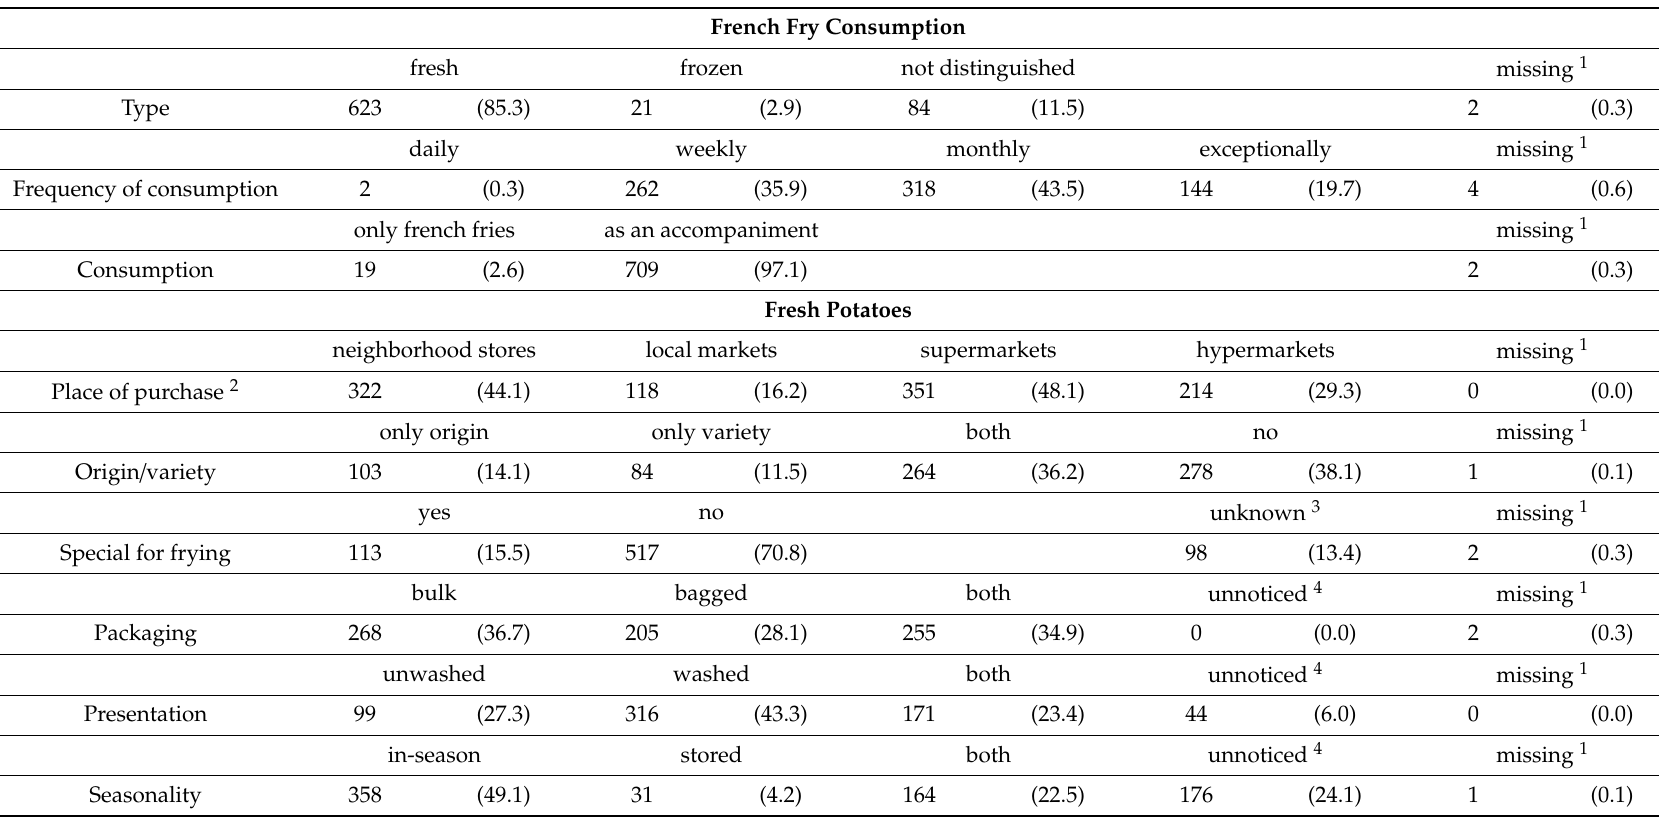
Table 2. French fry consumption and characteristics related to the use of fresh potatoes to prepare french fries in a Spanish population (number of cases,